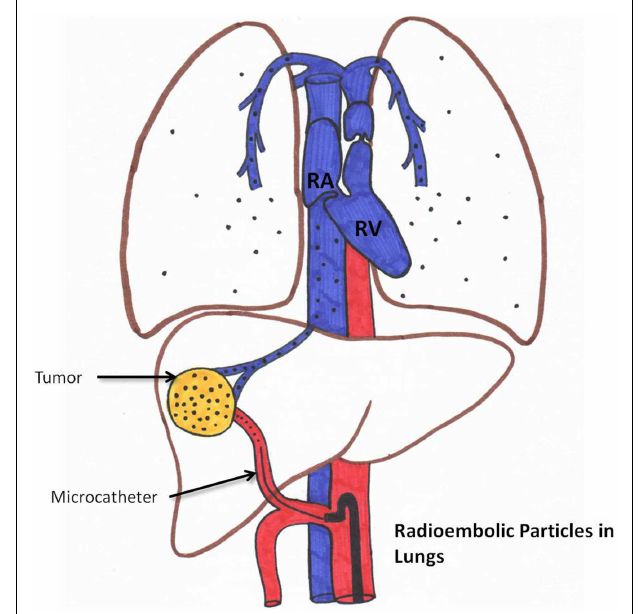
FIGURE 5 | Schematic representation of aberrant microsphere deposition in the lungs